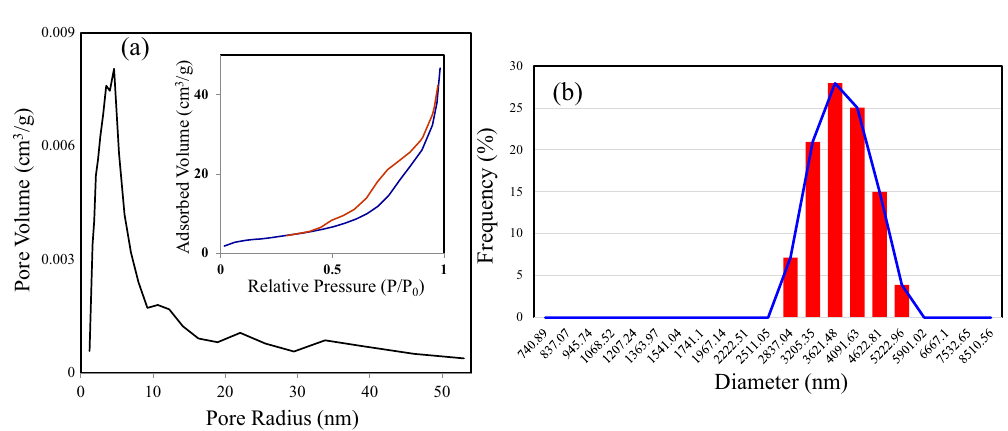
Figure 7. ( a ) The pore size distribution and the corresponding Nitrogen adsorption–desorption isotherm curves (inset) obtained from BJH and BET methods. ( b ) The size distribution of rGO/CuO–NHS obtained from DLS